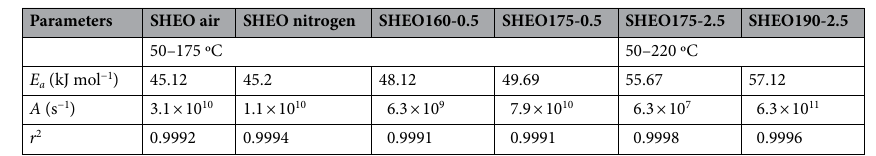
Table 3. Vaporation kinetic parameters of SHEO and SHEOx-y samples, where: r 2 is the linear correlation